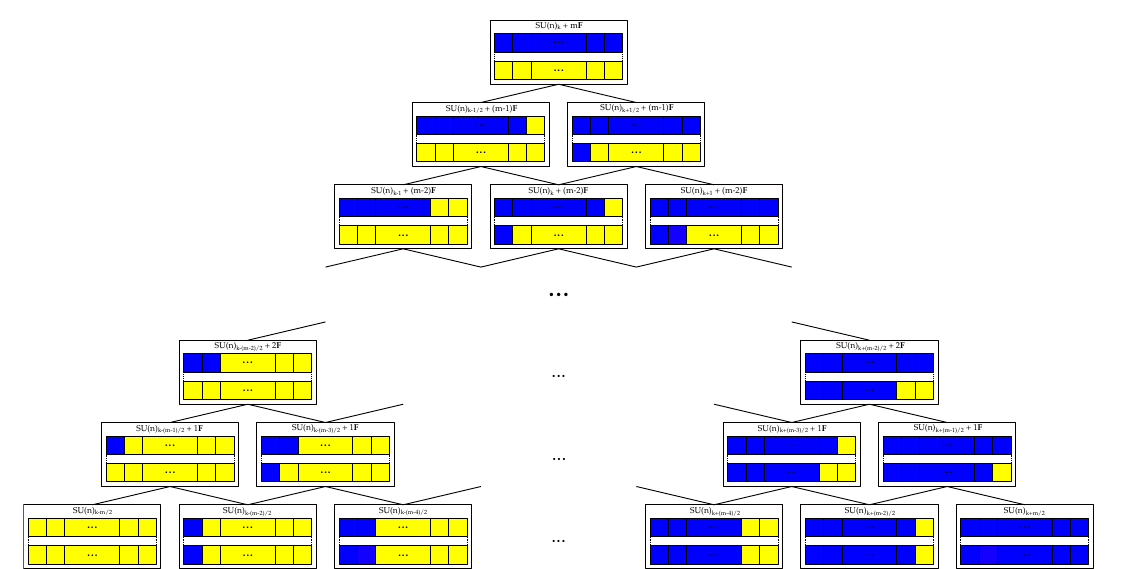
Figure 7. The (cid:13)op graph for the (cid:13)avor-equivalence classes of Coulomb phases associated to SU( N ) gauge theory with N f fundmental hypermultiplets. This is identical to the (cid:13)op graph for the Coulomb branches of all descendant gauge theories with matter in complex representations, as shown in